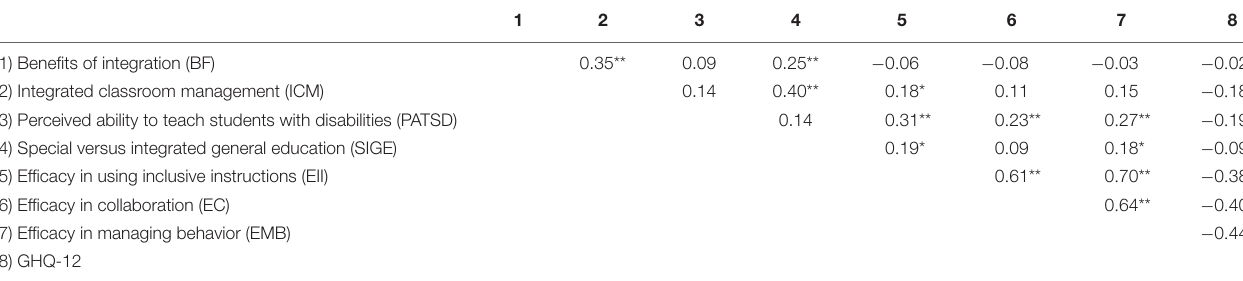
TABLE 3 | Correlations between the scores on the four ORI subscales, the three TEIP subscales, and the GHQ-12 score.